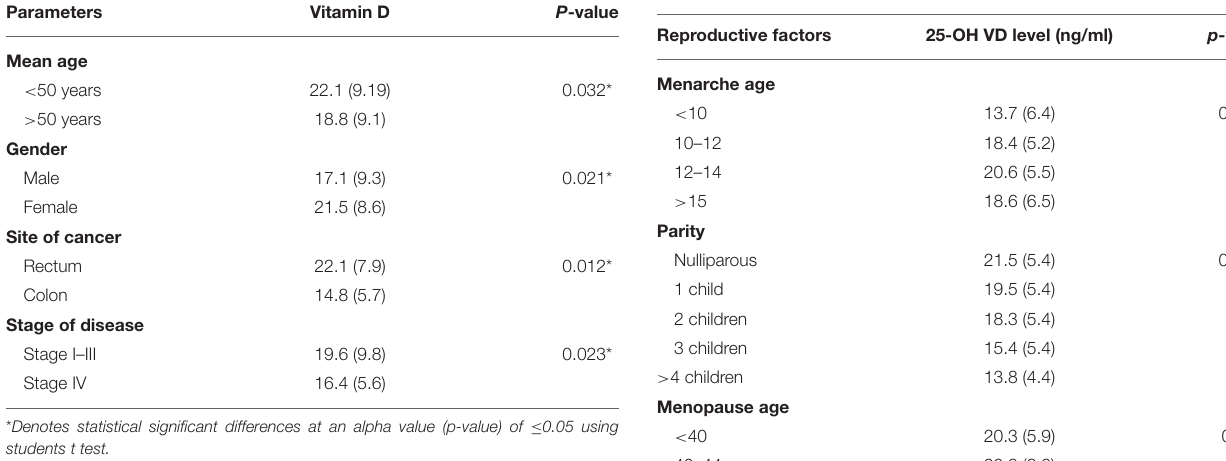
TABLE 5 | Reproductive factors and 25-OH VD concentration in female CRC patients ( n =